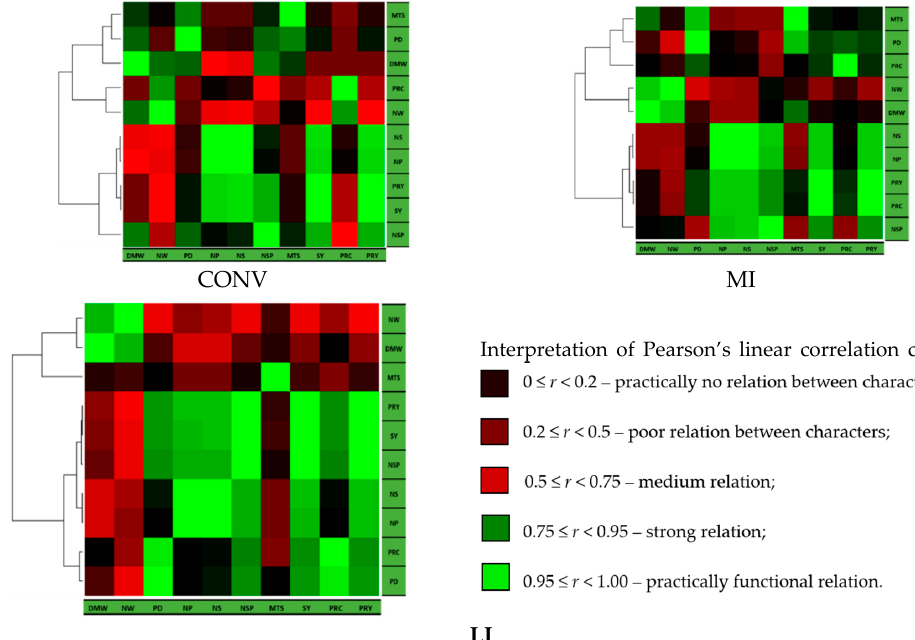
Figure 1. Correlation coe ffi cients between analyzed parameters. System (FS): LI = low input; MI = medium input; CONV = conventional. Parameters compared: DMW = dry mass of weeds; NW = number of weeds; PD = plant density; NP = number of pods / plant; NS = number of seeds / plant; NSP = number of seeds / plant pod; MTS = mass of 1000 seeds; SY = seed yield; PRC = protein content; PRY = protein